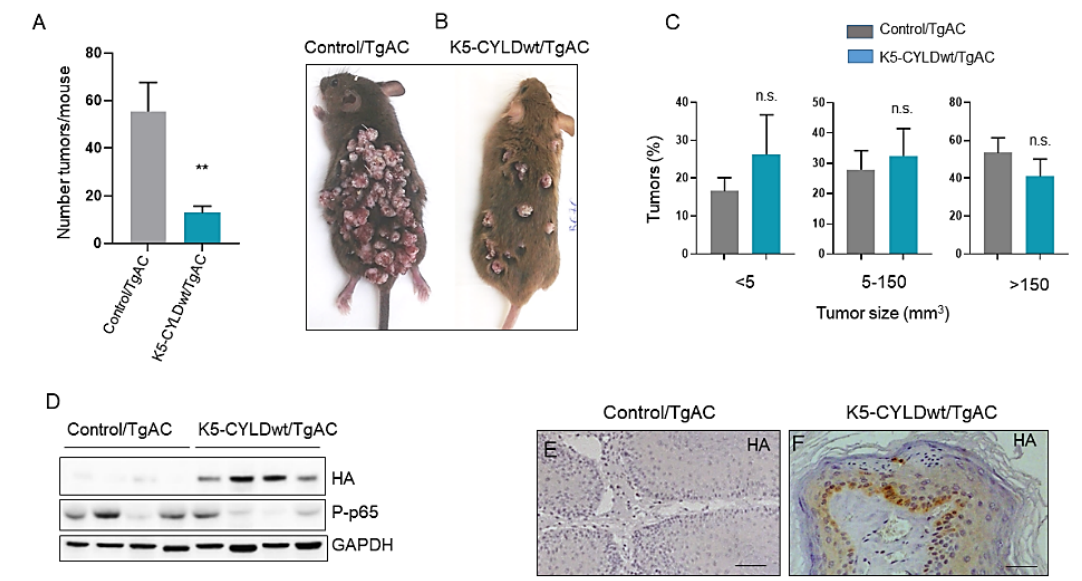
Figure 5. Inhibition of skin tumor development in K5-CYLDwt mice. ( A ) Graphical representation of the tumor multiplicity in Control/TgAC and K5-CYLDwt/TgAC mice showing the decrease in the number of tumors developed in the latter. Data are shown as mean ± SEM; ** p < 0.01 by two-tailed unpaired t test with Welch’s correction; n = 10 mice/genotype. ( B ) Representative images showing the reduction in the number of tumors in the skin of K5-CYLDwt/TgAC mice. ( C ) Representation of the percentage of tumors of the indicated size in each group of mice. Note a tendency to reduced size in K5-CYLDwt/TgAC tumors. Data are shown as mean ± SEM by two-tailed Mann–Whitney test; n.s.: statistically not significant. ( D ) WB showing that tumors arisen in K5-CYLDwt/TgAC mice expressed the transgene and showed inhibition of the activation of NF- κB. ( E , F ) Immunostaining with a specific anti-HA antibody showing the expression of the transgene in K5-CYLDwt/TgAC tumors ( F ). Scale bars: 30 µm ( E , F ).